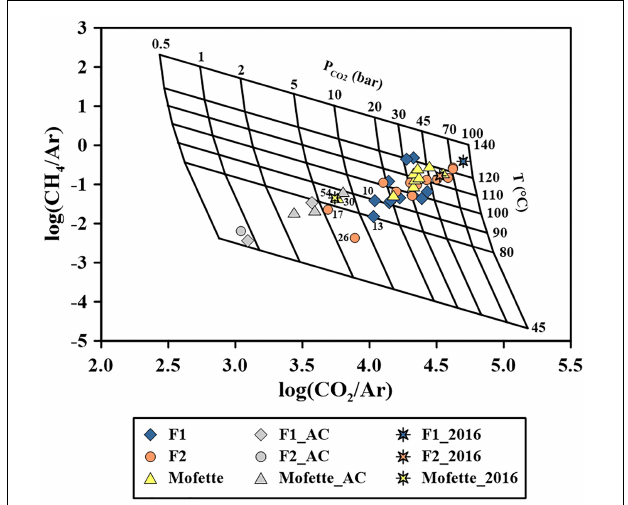
FIGURE 7 | Plot of log(CH 4 /Ar) vs. log(CO 2 /Ar) after Chiodini et al. (2007). The theoretical P CO 2 -T grids assume that the redox conditions are fixed by the D’Amore and Panichi (1980) buffer. The abbreviation _AC stands for air contamination, while data of samples collected during 2016 are from Bräuer et al.